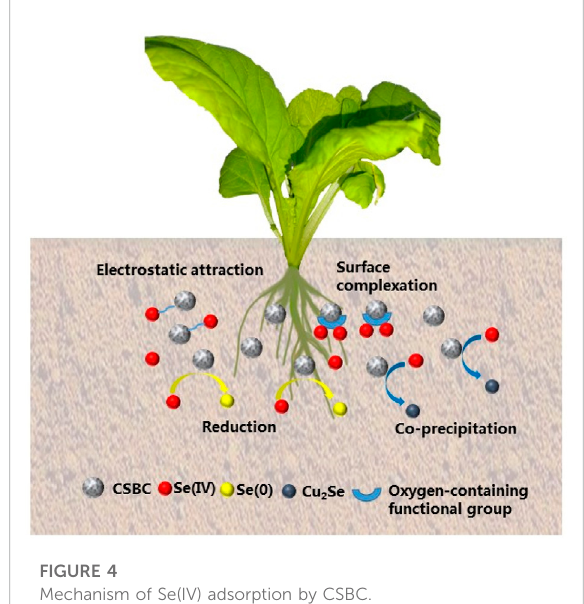
FIGURE 4 Mechanism of Se(IV) adsorption by